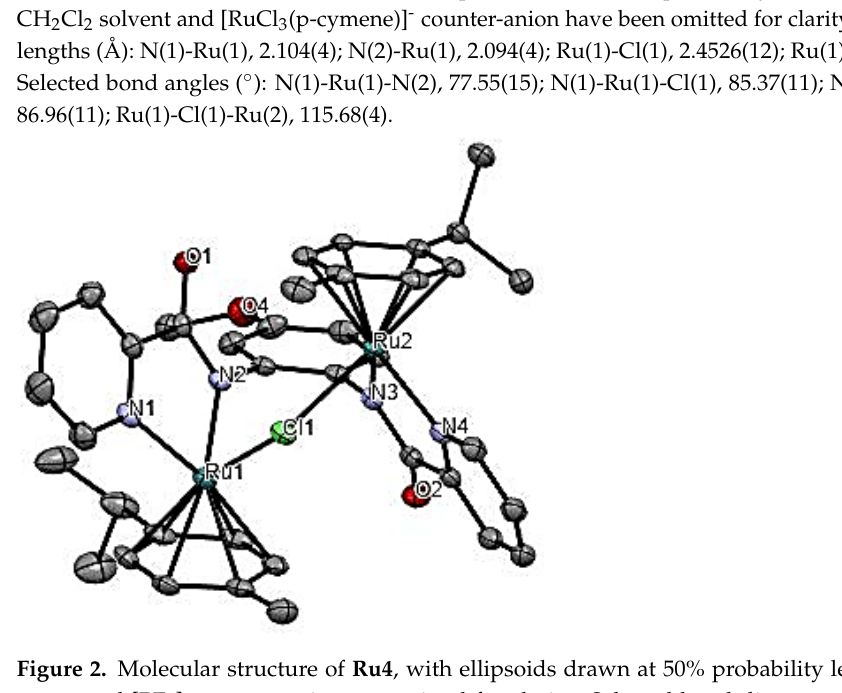
Figure 2. Molecular structure of Ru4 , with ellipsoids drawn at 50% probability level. Hydrogen atoms and [PF 6 ] – counter-anion are omitted for clarity. Selected bond distances (Å): N(1)-Ru(1), 2.097(2); N(2)-Ru(1), 2.081(2); Ru(1)-Cl(1), 2.4627(7); Ru(1)-Ru(2), 4.168(5). Selected bond angles ( ◦ ): N(2)-Ru(1)-N(1), 77.54(9); N(1)-Ru(1)-Cl(1), 83.23(7); N(2)-Ru-Cl(1),